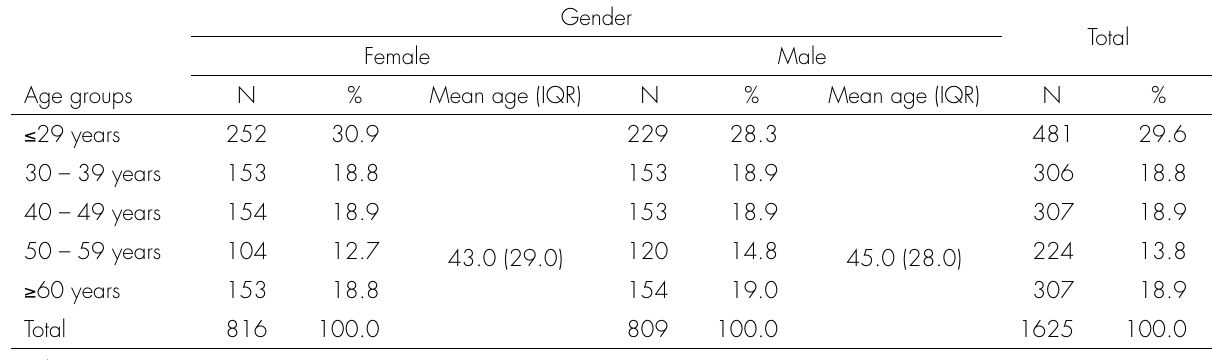
p value = (Z = 1.560; p =